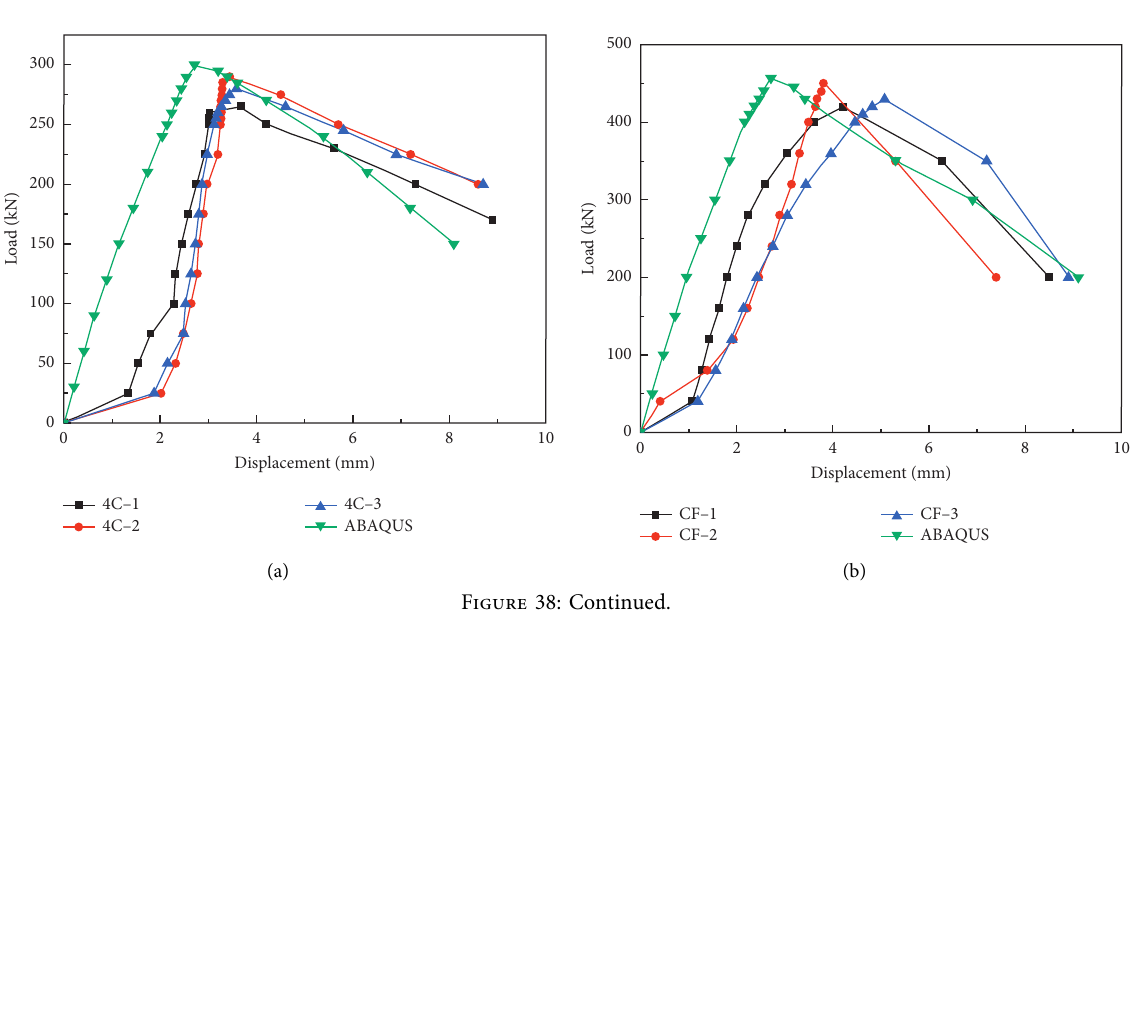
Figure 37: ZF-type failure mode: (a) front elevation and (b) side